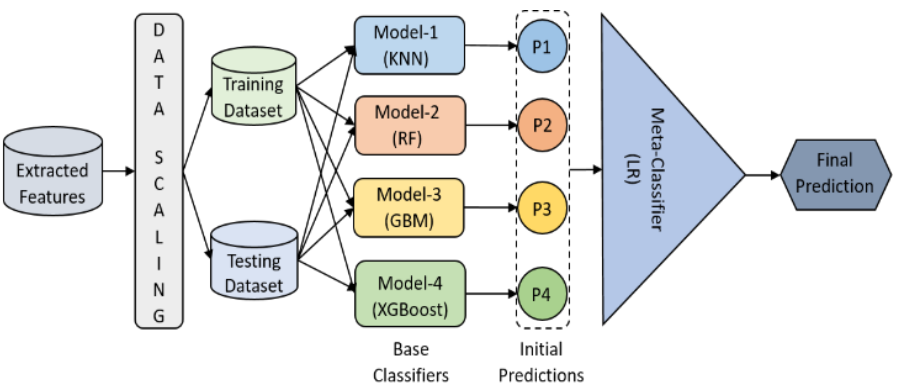
Figure 8. Machine learning stacking-based ensemble classification. The data were scaled before training and testing. The classification was carried out in two steps: initial and final predictions using base and meta classifiers, respectively.